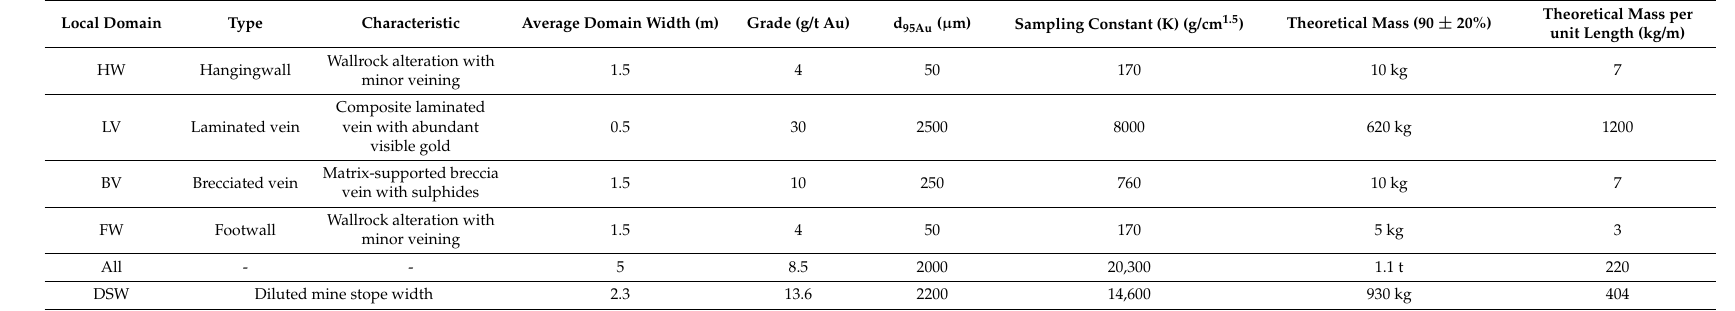
Table 9. Example of sampling characteristics for epithermal vein mineralisation across local domains.